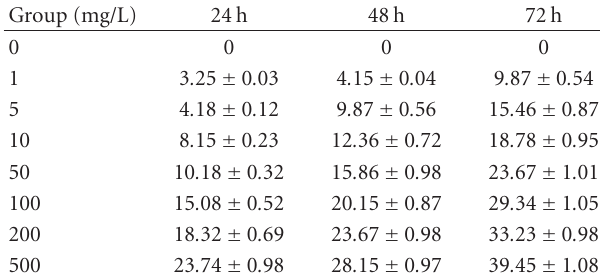
Table 1: E ff ects of endostar on growth inhibition rate of A549 cells under normoxia (%).